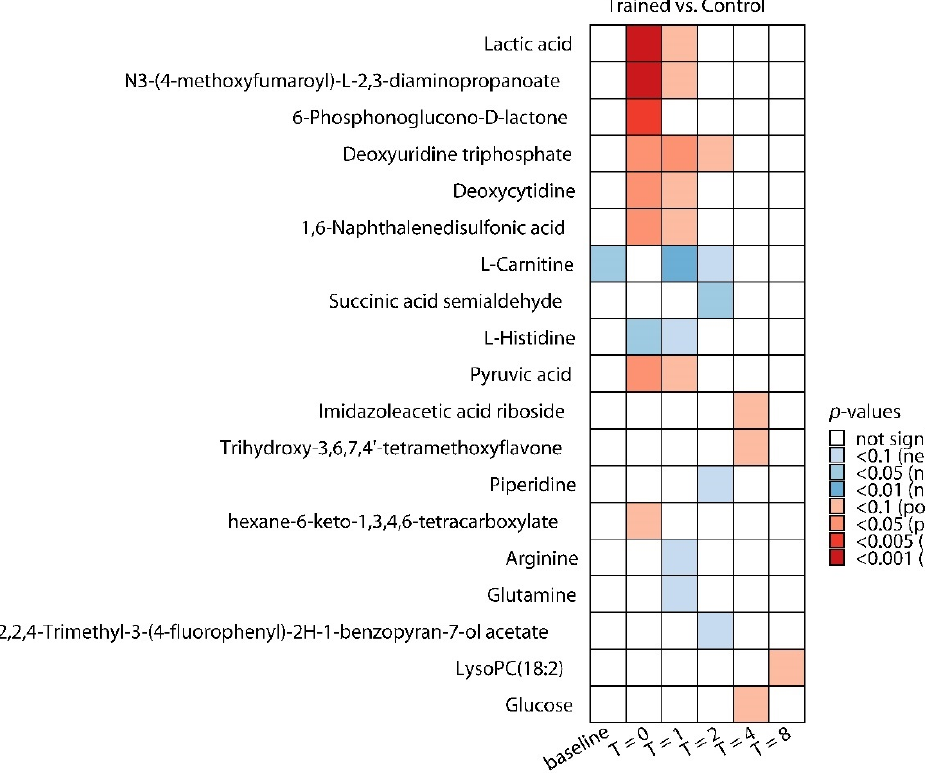
Figure 4. Differentially regulated metabolites in the trained group. Significantly regulated metabolites at baseline (one hour before LPS administration), T = 0 (immediately prior to LPS administration), and 1, 2, 4, and 8 h following LPS administration in the training group compared with the control group. Blue color indicates a decrease compared with the control group, red color indicates an increase compared with the control group. p -values were calculated using unpaired t-tests with multiple-testing correction (Benjamini–Hochberg false discovery rate [FDR]).